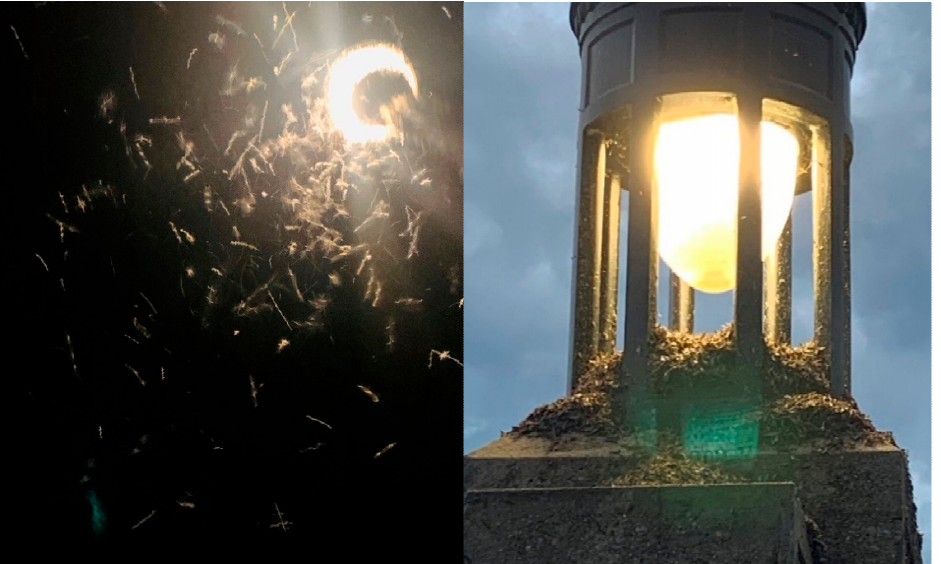
Figure 1. ( left ) Mayflies swarm at a light fixture along the riverbank near Veterans Memorial Bridge. ( right ) Accumulation of mayfly carcasses at bridge light fixture and concrete pier. In order to isolate some of the variables related to the existing lighting on the bridge, different trial scenarios were temporarily installed on-site; data was collected, and obser- vations were made during each trial. The data collection in the field took place in June, July, and August 2020, which is the primary time for mayflies to emerge from the river. Three locations (Spans 12, 20, and 28) separated by darkness were used to test the effect of different lighting conditions on the bridge in each trial, as shown in Figure